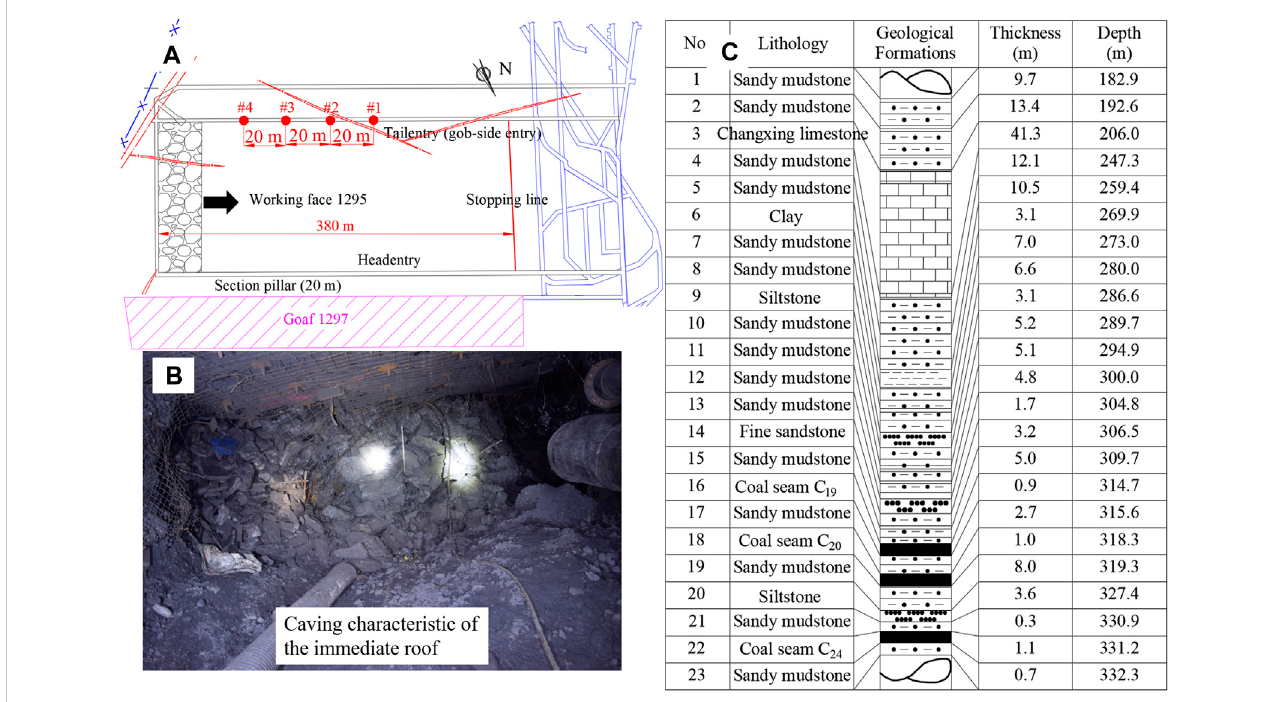
FIGURE 1 Working face 1295. (A) 1295 plane diagram. (B) 1295 tail entry. (C) Geologic column.